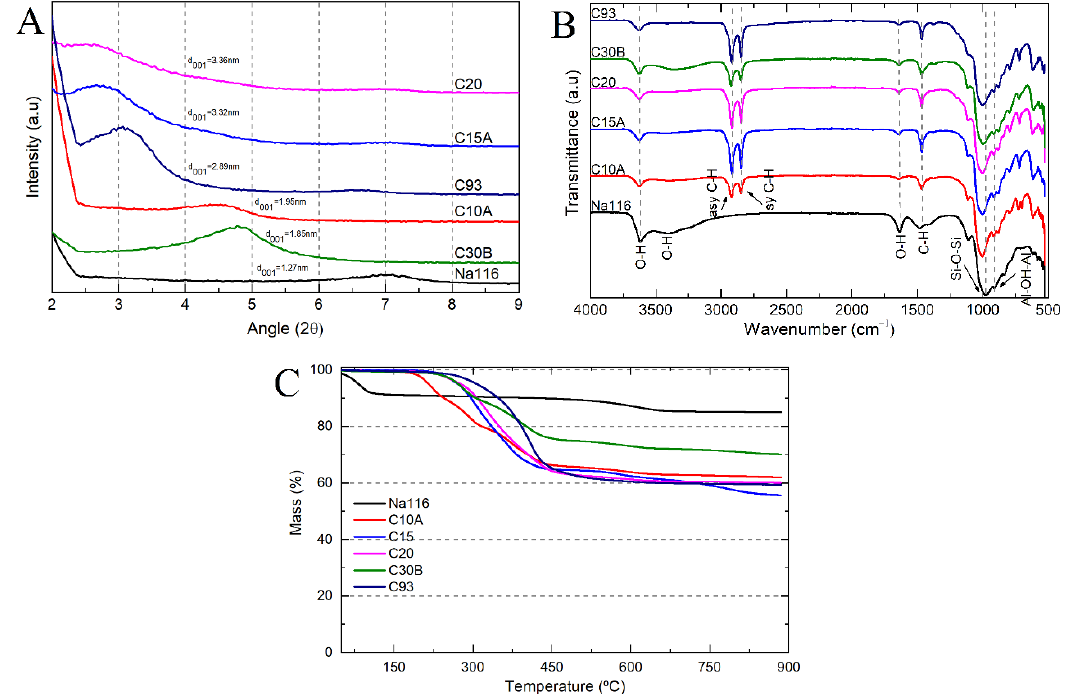
Figure 5. ( A ) Clay basal spacing obtained from x-ray diffraction (XRD) measurements; ( B ) clay Fourier transform infrared (FTIR) spectra; and ( C ) clay degradation stages as a function of temperature.